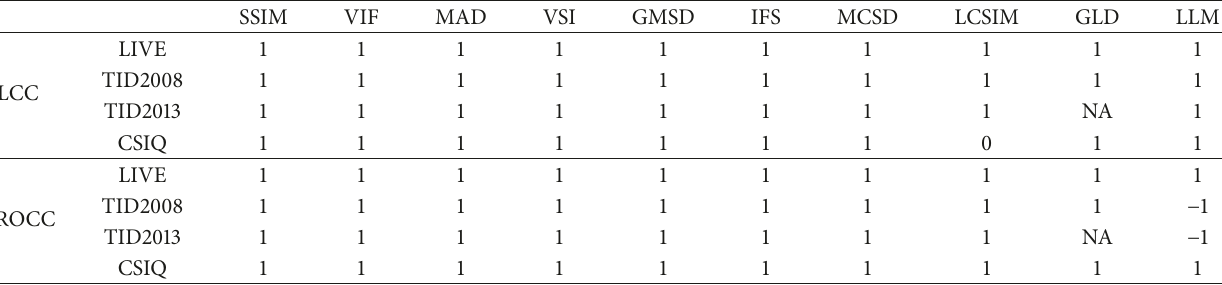
Table 6: Significance testing results of PLCC and